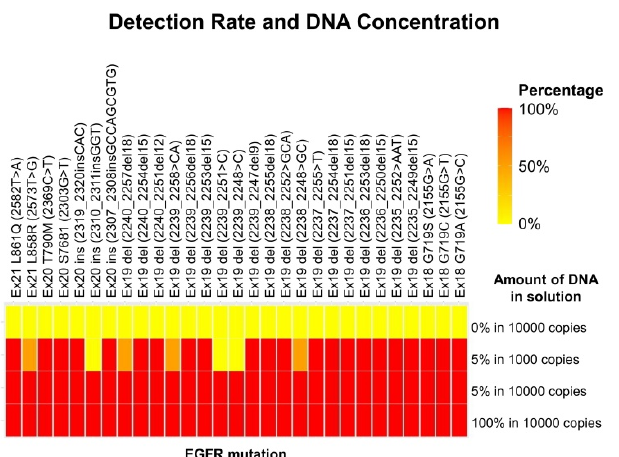
Figure 3. The relationship between results of the LAMP assay and DNA concentrations. The x -axis shows 4 concentrations, and Y -axis presents 29 subtypes of EGFR mutations. The LAMP assay detected all EGFR mutations over 5% in 10,000 copies.